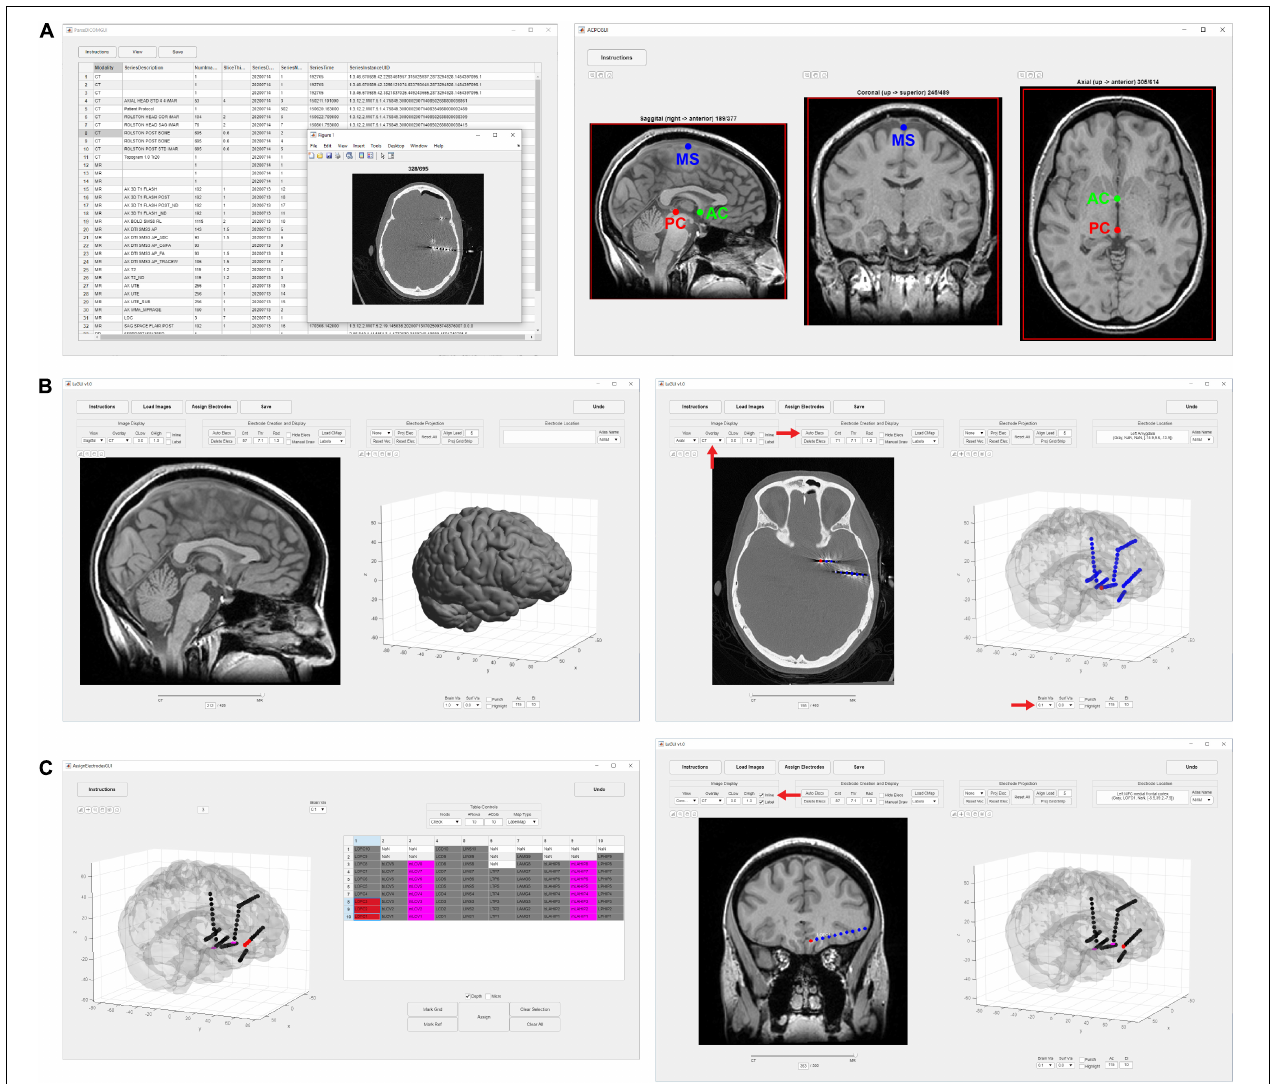
FIGURE 1 | Flow chart of processing steps. (A) Image selection and saving (left) with ACPC alignment for MRI images (right). AC, PC and mid-sagittal (MS) points are shown in green, red, and blue, respectively. (B) Results after coregistration, segmentation, and MNI normalization steps (left). Gray and white segmented tissue types are used to generate a 3D brain surface. Automatic electrode detection results using coregistered CT (right). The opacity of the MRI image can be decreased to show the CT image with superimposed electrodes. The brain surface can be made transparent or hidden to visualize electrodes in 3D display. (C) User interface for electrode labeling and channel assignment (left). Assignments are color coded for visual clarity. Selected table values and corresponding assigned electrodes are shown in red. Assignments are populated into the main LeGUI interface after closing the assignment interface window (right). Inline projection of selected SEEG leads allows visualization of the entire lead relative to a single MRI slice